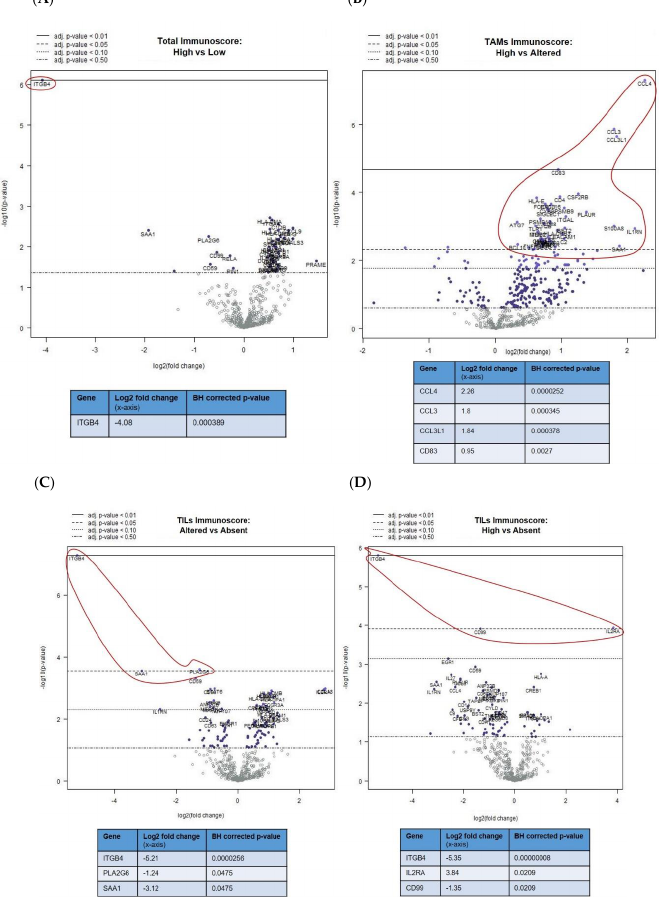
Figure 2. Differential gene expression profiles presented as volcano plots for: ( A ) total immunoscore of “high” versus “low” for all mUM, as previously defined, ( B ) tumour-associated macrophages (TAMs) immunoscore for all mUM illustrating “high” versus “altered,” the tumour infiltrating lymphocytes (TILs) immunoscore for all mUM showing ( C ) “altered/intermediate” versus “absent/cold,” and ( D ) “high/hot” versus “absent/cold.” For each volcano plot, the log 2 fold changes with cutoffs for adjusted p -values are shown. The genes of interest (marked fold changes and statistically significant) are highlighted (red outline and inset table). (Table S2A–D gives more detailed output for each gene). When undertaking DE analysis comparing the mUM with control liver, 11 genes had significantly increased expression (adjusted p < 0.01), ten of which had a log 2 fold-change greater than 2. (Figure 3A; Table S3A). These included: DUSP4 (dual specificity phosphatase 4), PRAME (Preferentially Expressed Antigen in Melanoma; Cancer-Testis (CT) antigen), CD44 , IRF4 (Interferon Regulatory Factor 4, also known as Multiple Myeloma Oncogene 1 [MUM1]) , MFGE8/lactadherin , BCL2 (B-cell lymphoma 2 ) , CD146/MCAM ( Melanoma Cell Adhesion Molecule) /MUC18 ; IGF1R ( insulin-like growth factor 1 receptor ) , PNMA1 (paraneoplastic Ma antigen protein family; CT antigen); and LGALS3/Galectin-3 (Figure 3A, Table S3A, and Figure S2A). Furthermore, DE analysis comparing nBAP1-ve versus nBAP1+ve mUM revealed significant downregulation of AKT3 (adjusted p < 0.05) (Figure 3B and Table S3B). A number of other antigen processing–related, cytokine, chemokine, T-cell and NK-cell function related genes were downregulated in nBAP1-ve mUM but did not reach statistical significance (Figure 3B and Table S3B).